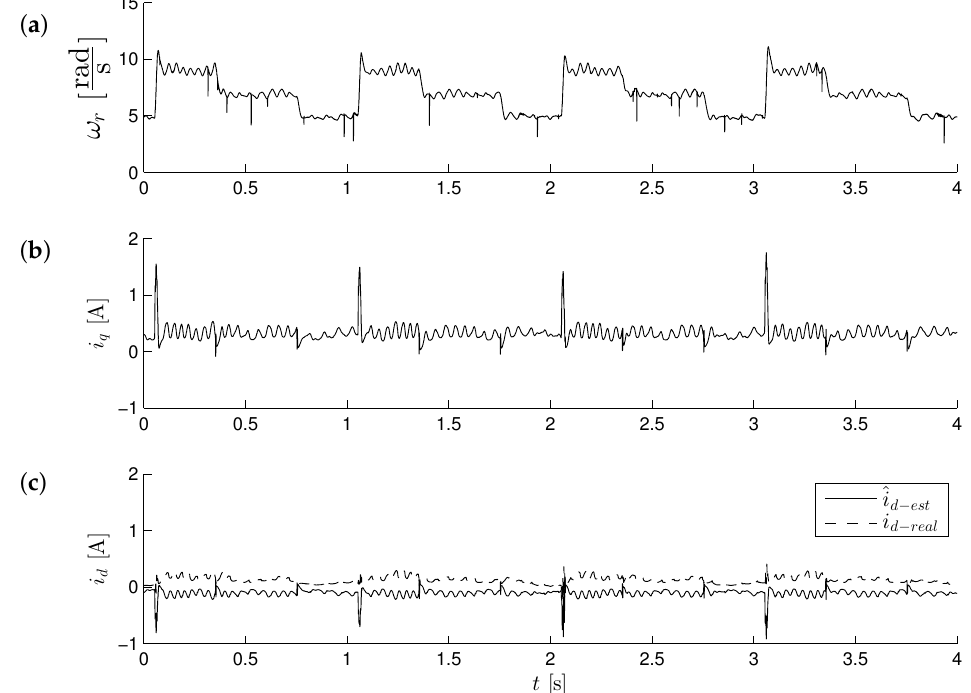
Figure 18. Experimental behavior of low-speed control structure operation during speed changes ] . Values of motor speed ω r ( a ), currents i q ( b ) and i d ( c ) ω ref = 8.8 6.8 4.8 [ rad s → →